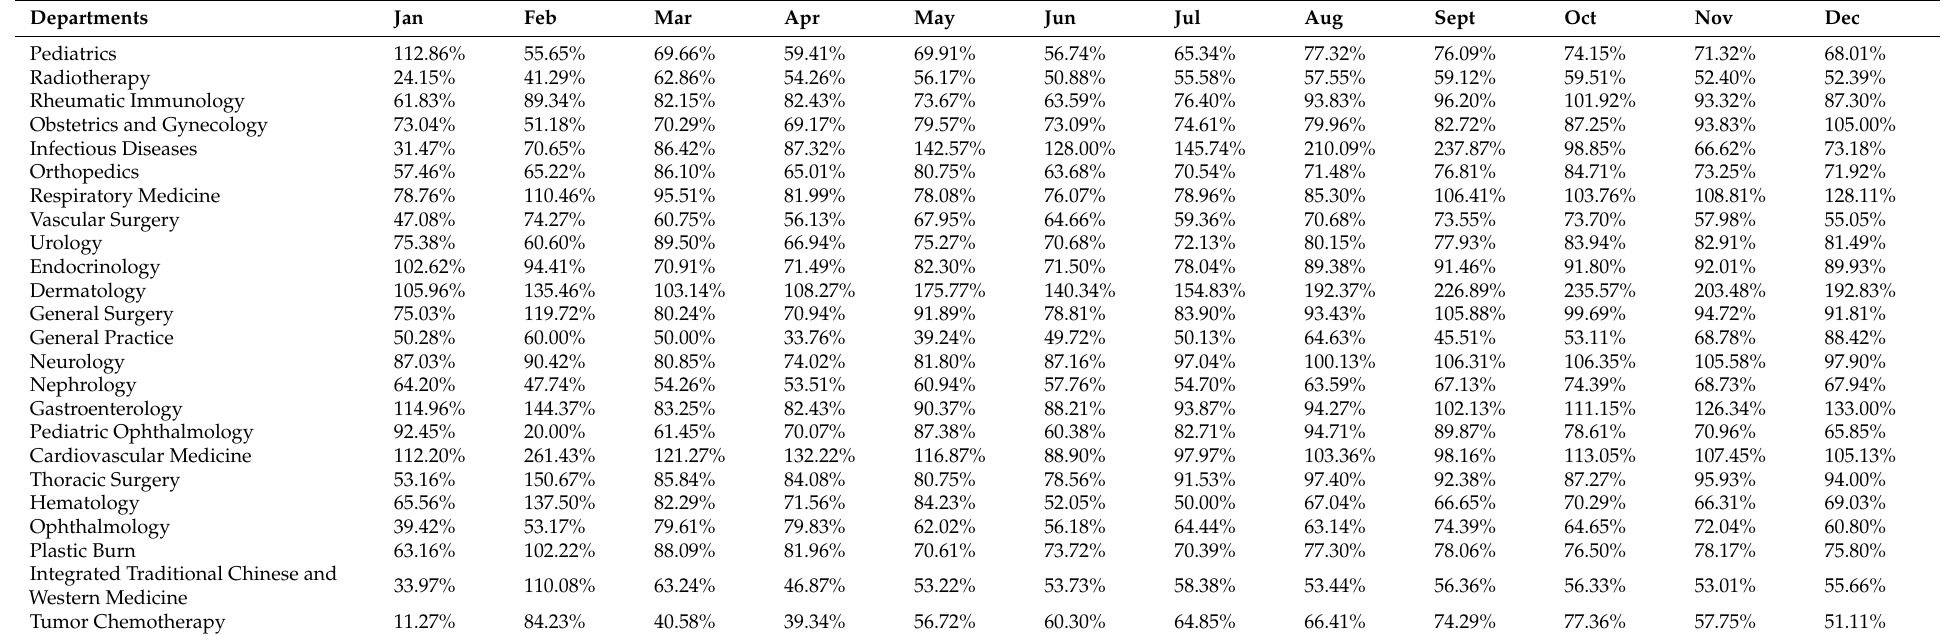
Table 2. Monthly departmental patient reservation